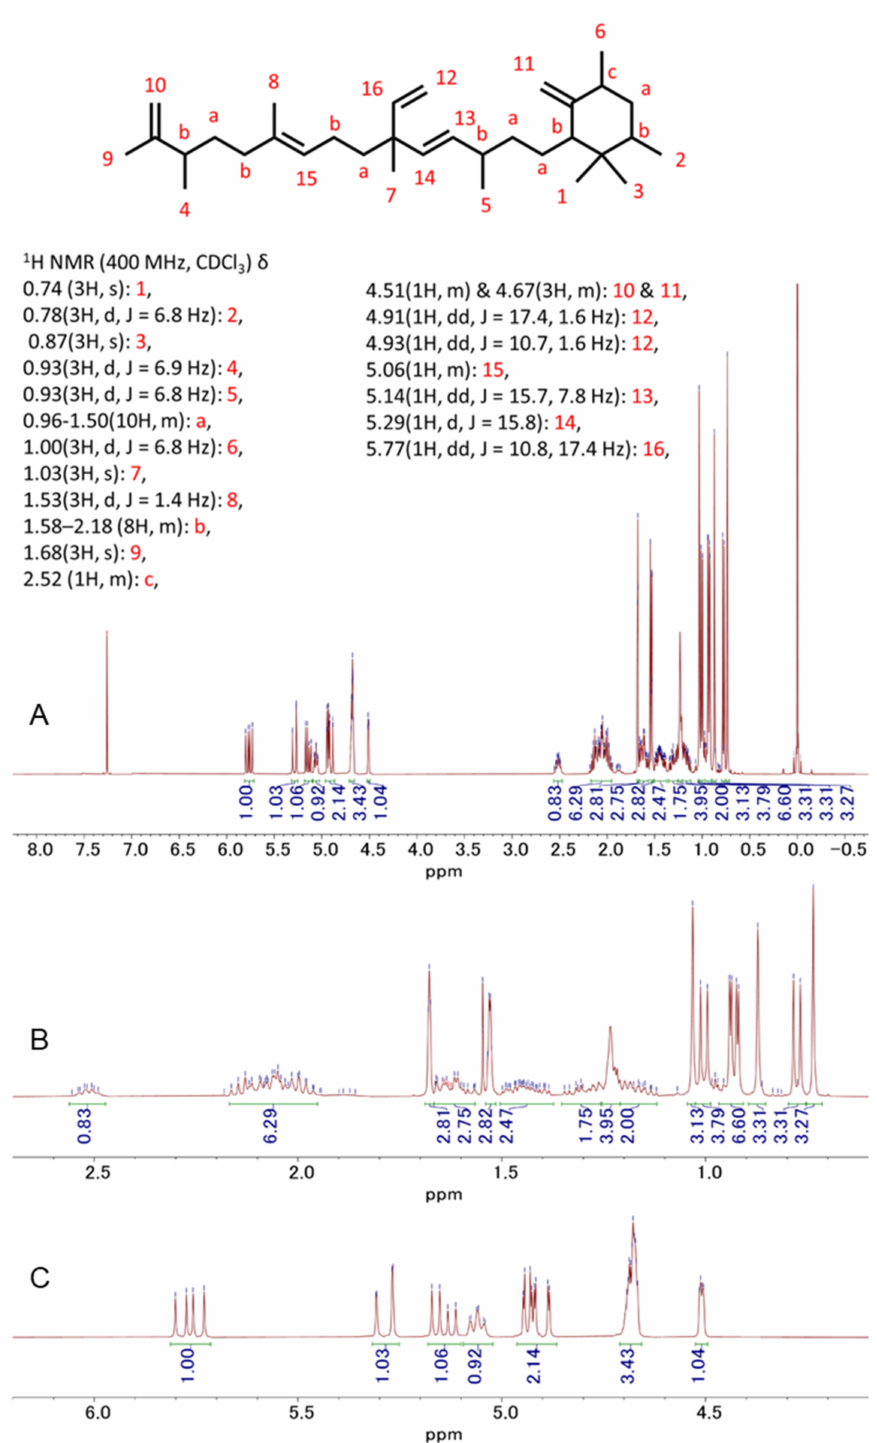
Figure 5. 1H-NMR spectra of me-meijicoccene in CDCl3 at 25 ◦ C: ( A ) whole spectrum; ( B , C ) partial